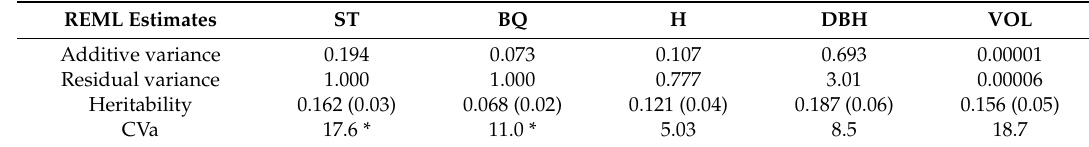
Table 2. Restricted Maximum Likelihood (REML) estimates of variance components and narrow-sense heritability (standard error in parenthesis) for stem straightness (ST), branching quality (BQ), total tree height (H), diameter at breast height (DBH) and stem volume (VOL), evaluated in full- and half-sib families of Eucalyptus globulus Labill. REML: Restricted Maximum Likelihood, CVa: coefficients of additive genetic variation.